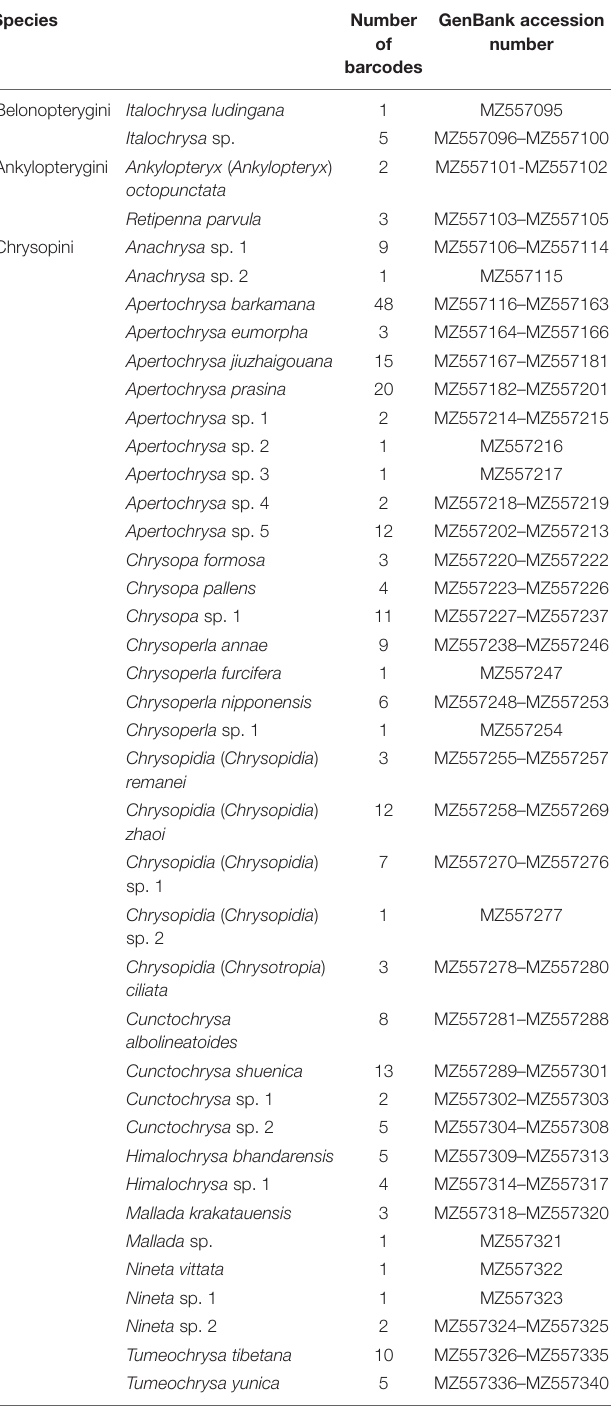
TABLE 2 | The DNA barcodes of Chrysopidae from the Shaluli Mountains. Species Number